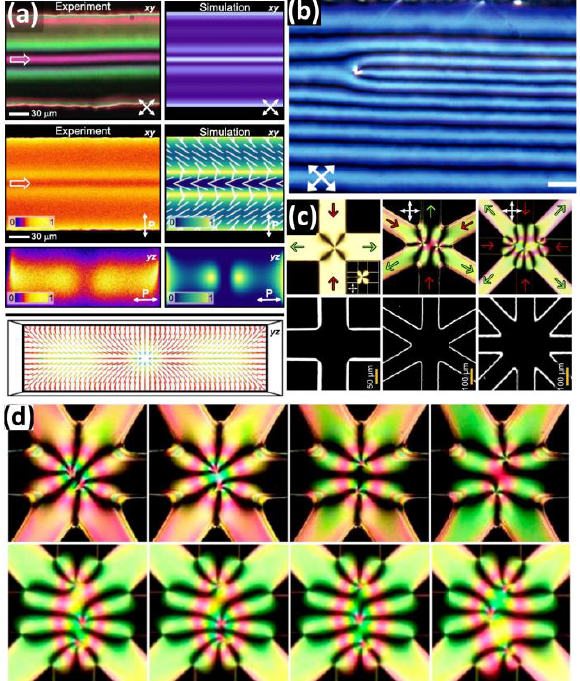
Fig. 2. Topological Microfluidics allows manipulation of director and defect topology toward novel optofluidic concepts. (a) Tunable complex flow-induced director field observed in microfluidic channels with homeotropic anchoring modulation, observed in both experiments and simulations. The topology of the director field can be modified by altering the microfluidic geometry, surface anchoring, and flow rates [34]. (b) Formation of a π -wall due to the nematic microflow in a channel with degenerate planar surface anchoring. The leading defect (bright spot) evolves spontaneously, which over time, reduces in length and stabilizes by aligning vertically within the channel [27]. (c) Microfluidic geometry can be harnessed to program the topology of nematic defects, shown here for generating effects of strength -1, -2 and -3 [19]. (d) Higher strength topological defects and lower multiples thereof (each with -1 strength) can be spatio-temporally manipulated by hydrodynamic flows [19]. The images are adapted from works of the author (Refs.